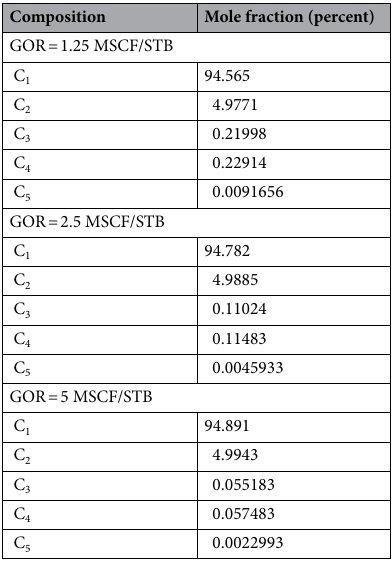
Table 1. The composition of rich gas with